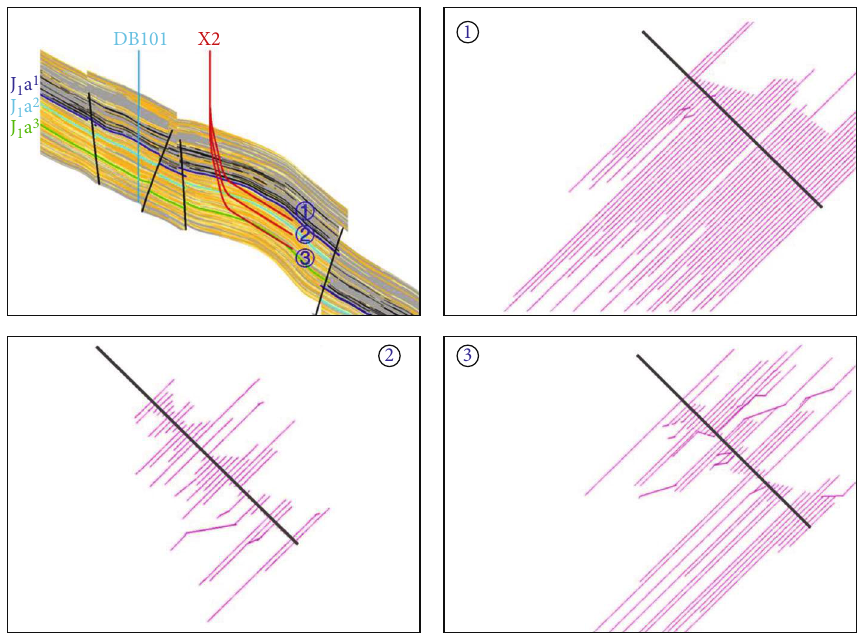
Figure 16: Simulation of the in fl uence of di ff erent landing points on the fracture